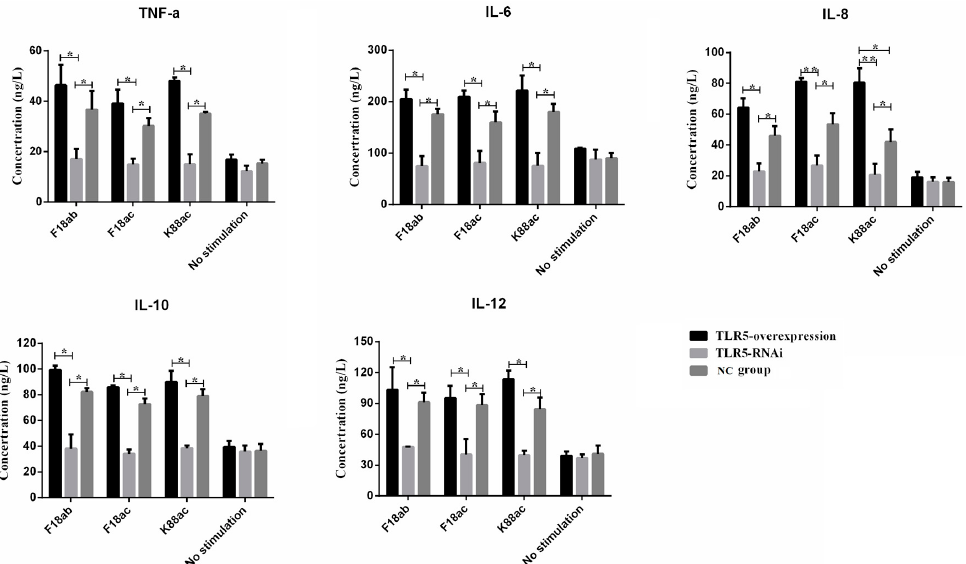
Figure 4. Release level of inflammatory cytokines from IPEC-J2 cells following E. coli stimulation. Inflammatory cytokines including TNF- α , IL-6, IL-8, IL-10, and IL-12 was detected by ELISA. *, p < 0.05; **, p < 0.01.